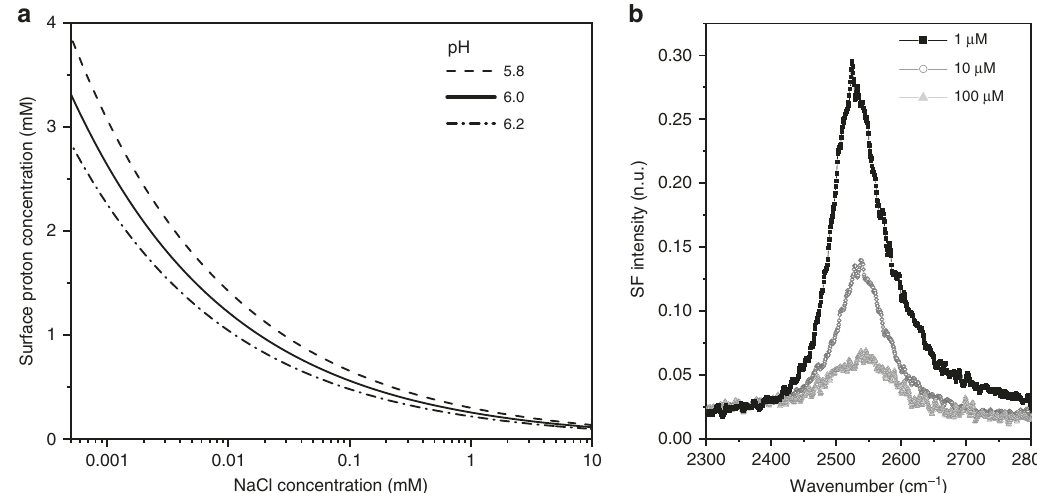
Fig. 5 Salt dependence of the hydrated proton spectral feature: theory compared with experiments. a Calculated surface proton concentration as a function of NaCl in the subphase of a fatty acid Langmuir monolayer based on the Gouy Chapman model, for three different pH. b VSF spectra in the SPS polarization of a dAA monolayer on an aqueous subphase with varying concentrations of NaCl at natural pH (surface pressure 20 mN m − 1 , temperature 22 °C). Note that the H 3 O + antisymmetric stretch intensity follows the same trend predicted for the surface proton concentration as a function of